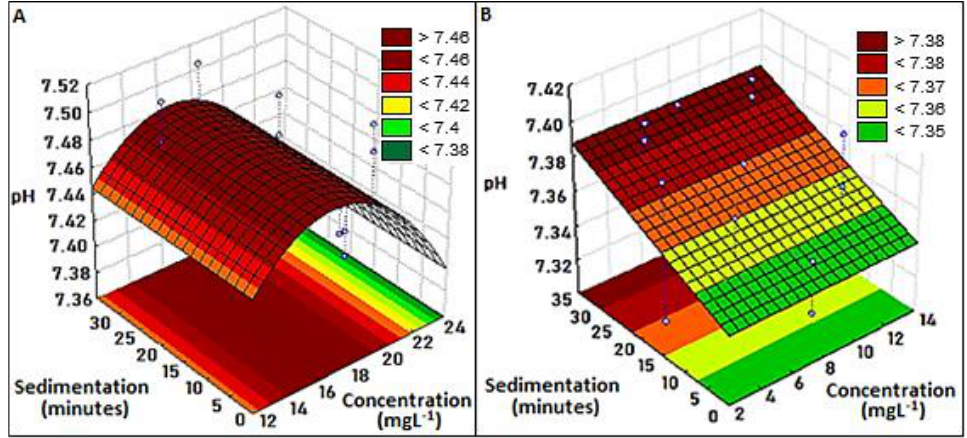
Figure 3. pH treatment surface graphs using magnetite associated with ( A ) tannin and ( B ) Moringa oleifera .